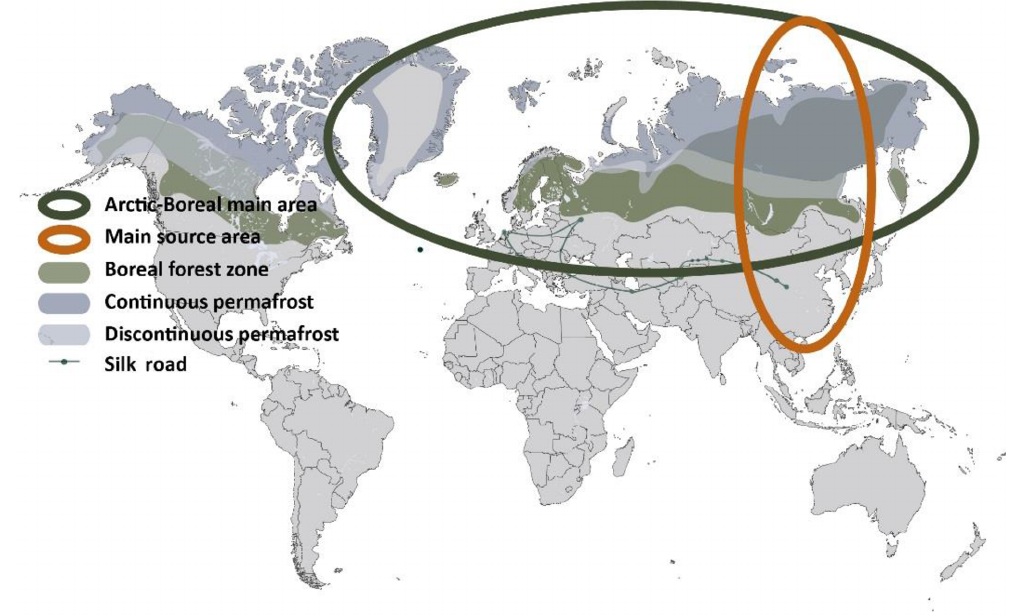
Figure 2. The northern pan-Eurasian geographical region encompasses both permafrost and boreal